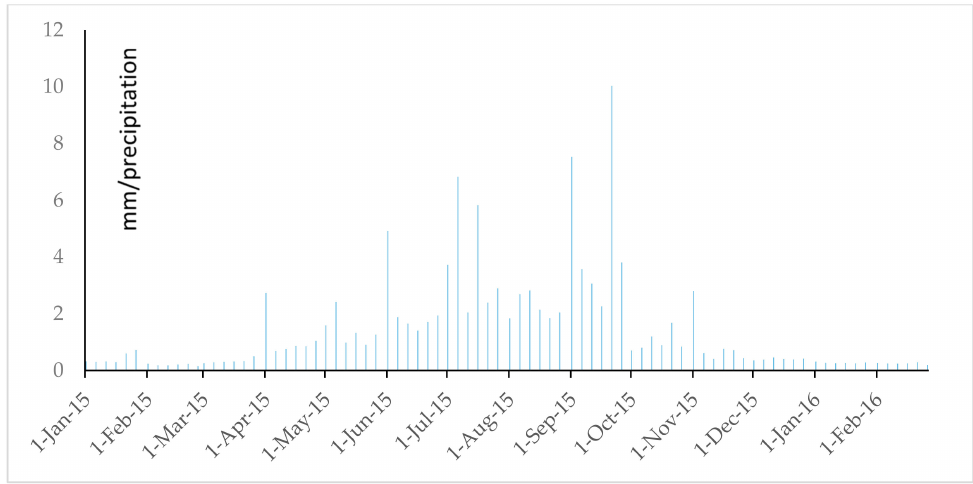
Figure A43. Precipitation of Denko County in 2015 and